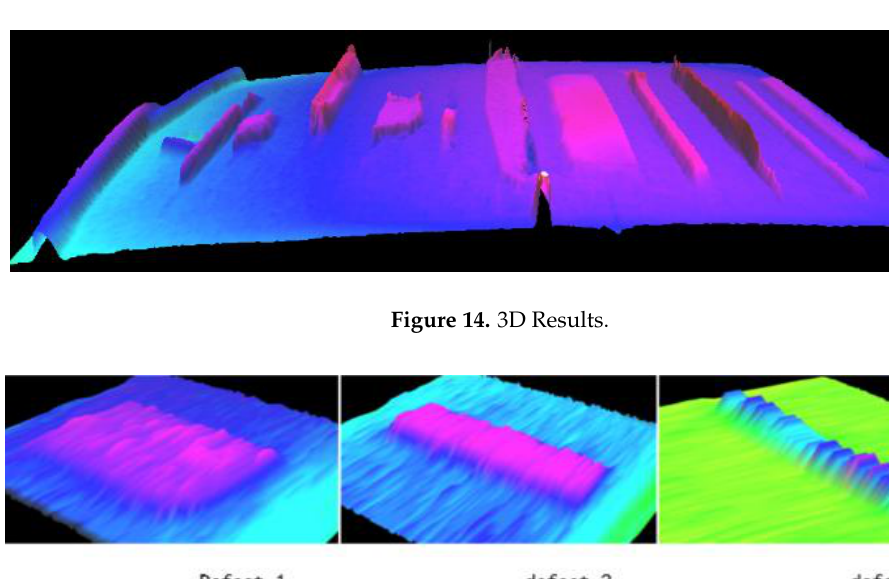
Figure 13. Simulated Defects.